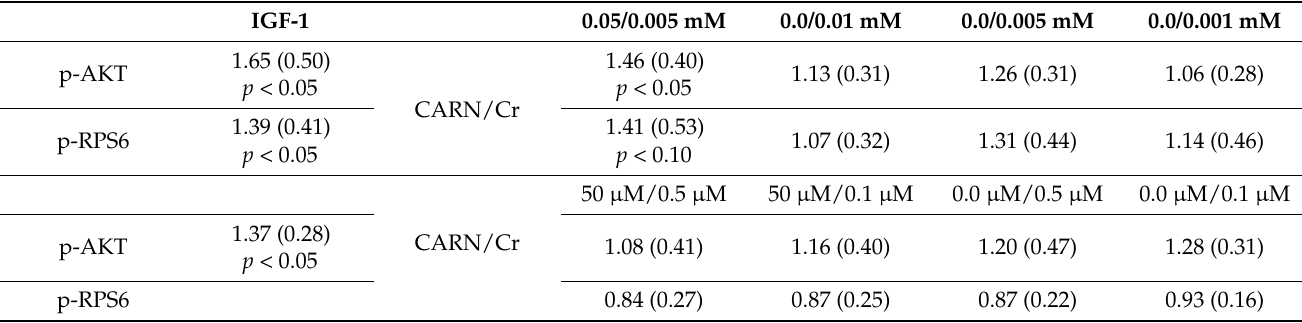
Figure 1. Effects of L-carnitine and creatine at 0.05 and 0.1 mM individually or in combination on muscle protein synthesis. IGF-1 used as a positive control increased protein synthesis by 1.34 ± 0.08 and L-carnitine/Creatine at 0.1/0.1, 0.05/0.05, 0.05/0 and 0/0.05 mM by 1.34 ± 0.09, 1.38 ± 0.04, 1.27 ± 0.1 and 1.13 ± 0.09, respectively from vehicle control. Significance was determined by unpaired t -tests. * p < 0.05. Table 1. Phospho-AKT and RPS6 expression in response to varying doses of L-carnitine (CARN) and creatine (Cr). IGF-1 is positive